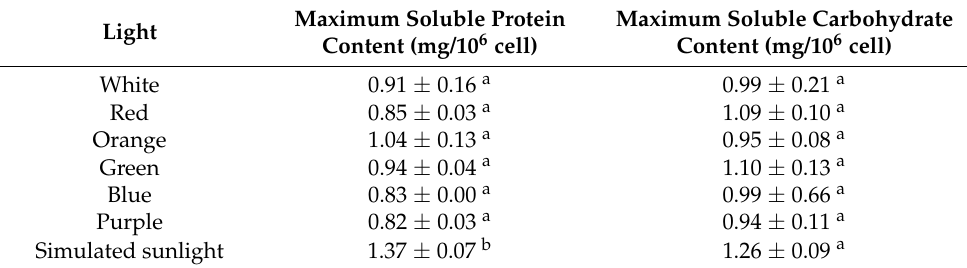
Table 2. Soluble protein (as BSA equivalent) and soluble carbohydrate (as glucose equivalent) in I. zhanjiangensis cultured under seven LED